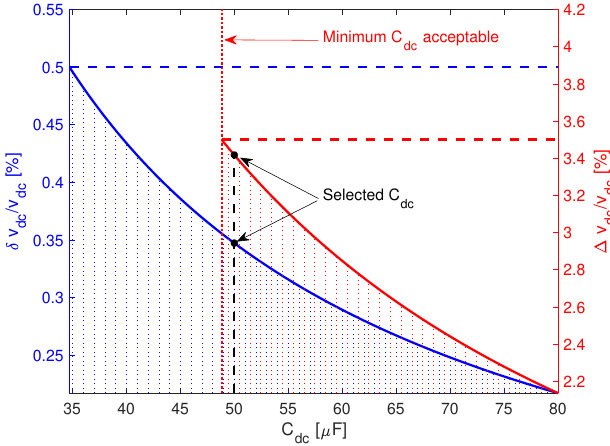
Figure 8. δ v dc / v dc and ∆ v dc / v dc for different C dc values.